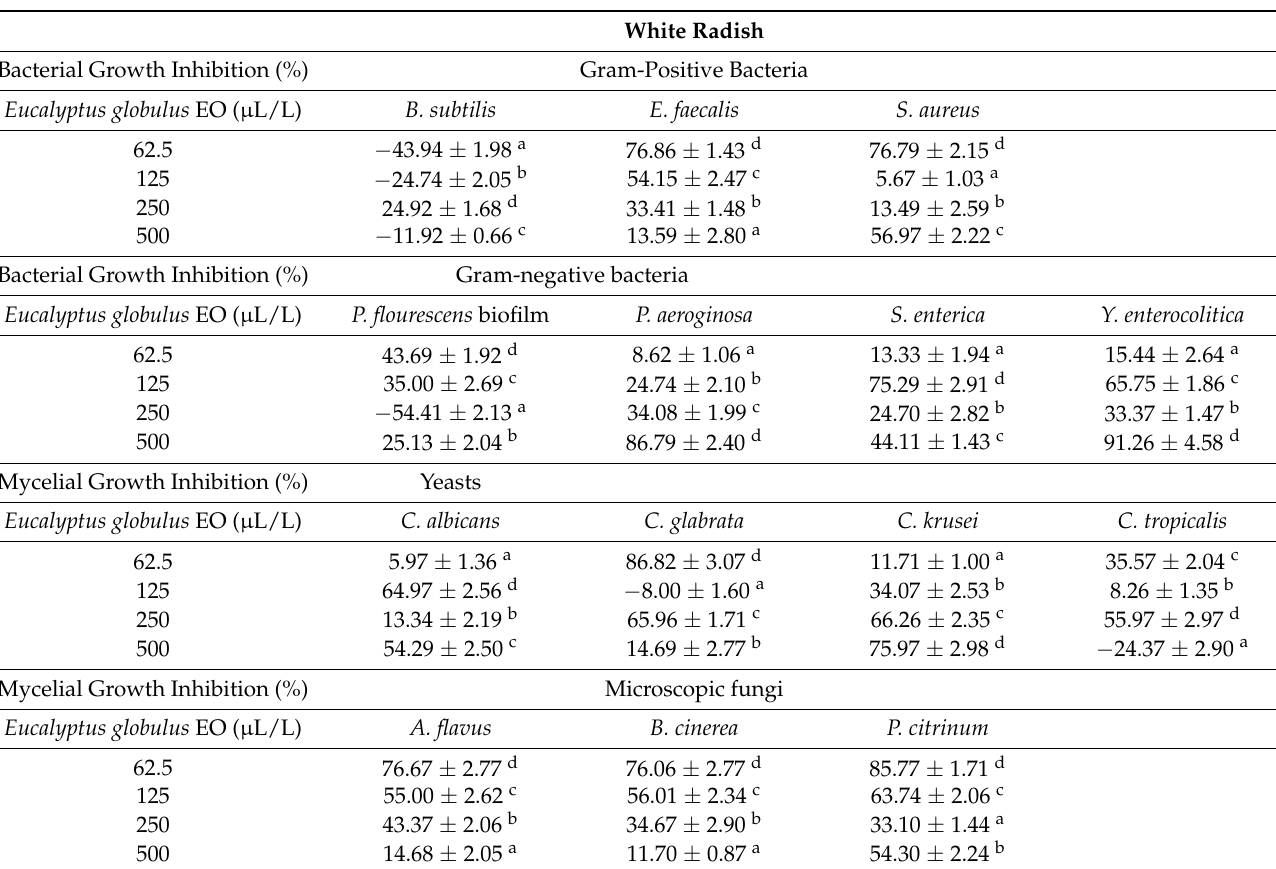
Table 6. In situ analysis of the antimicrobial activity of the vapor phase of Eucalyptus globulus essential oil on white